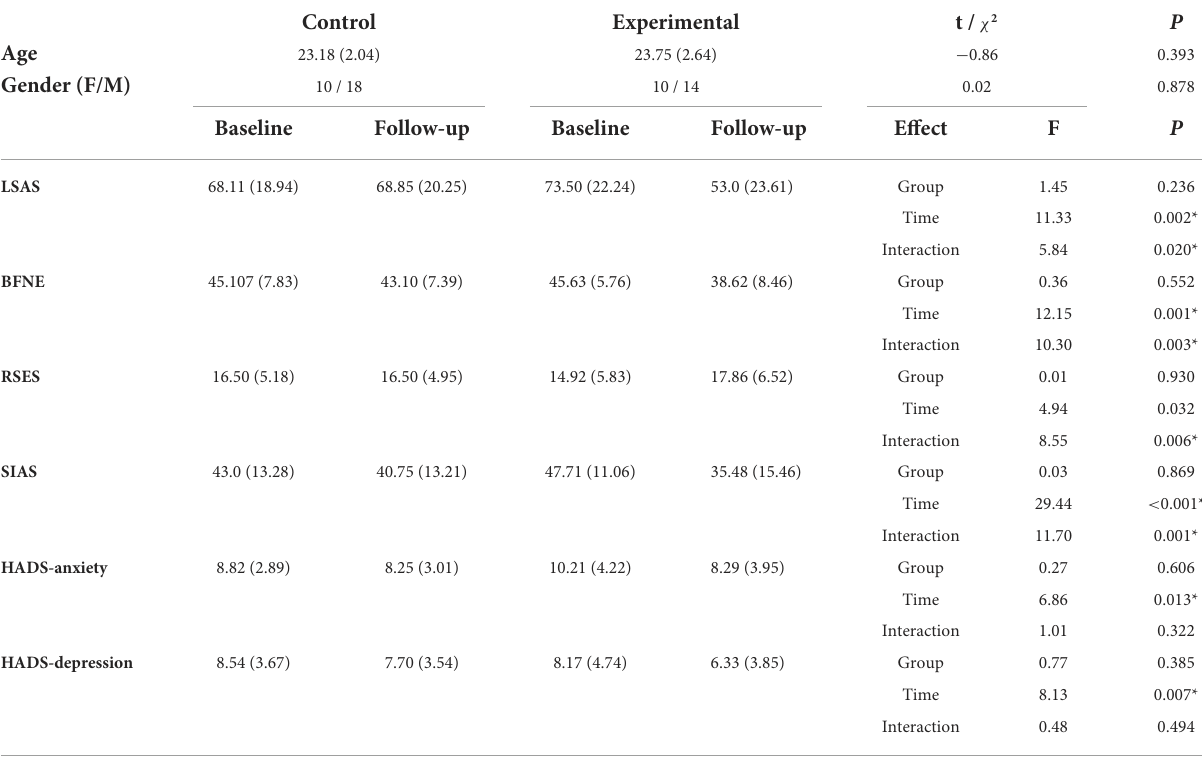
TABLE 1 Results of statistical analyses on age, gender and self-report questionnaire scores of participants. Control